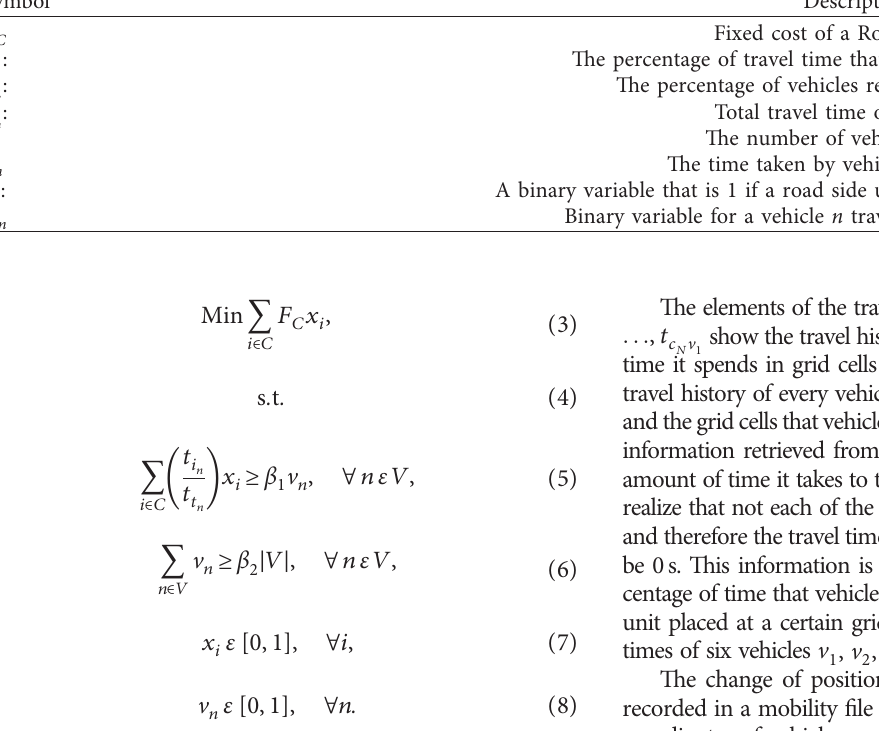
Table 1: Notations used in the Optimization Problem (Parameters used and their descriptions).